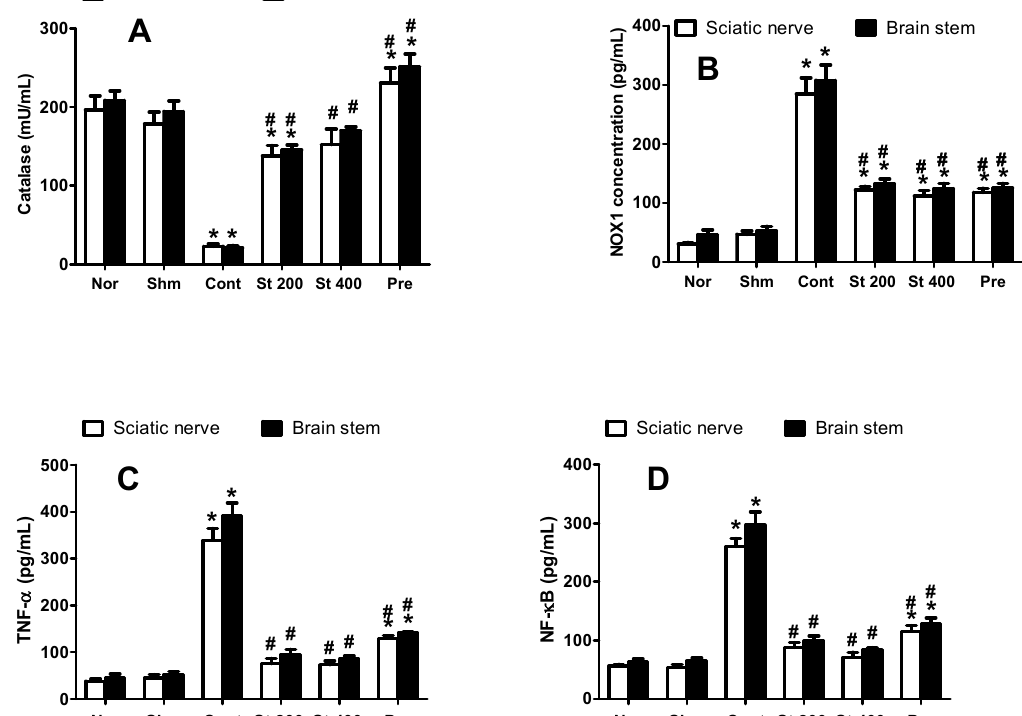
Figure 4. Effect of S. tetrasperma extract (200 and 400 mg/kg, p.o.) on CCI-induced on catalase activity ( A ), NOX1 level ( B ), TNF- α ( C ) and NF- κ B ( D ) levels in the sciatic nerves and brain stems of CCI rats. Values are given as mean ± SEM, n = 5 rats per group. * p < 0.05, compared to Sham group; # p < 0.05, compared to CCI group. NOX1, NADPH oxidase; NF- κ B, nuclear factor kappa B; TNF- α , tumor necrosis factor alpha. Norm means normal group; Shm means Sham group; St 200 and St 400 mean S. tetrasperma extract (200 and 400 mg/kg) and pre means pregabalin group.